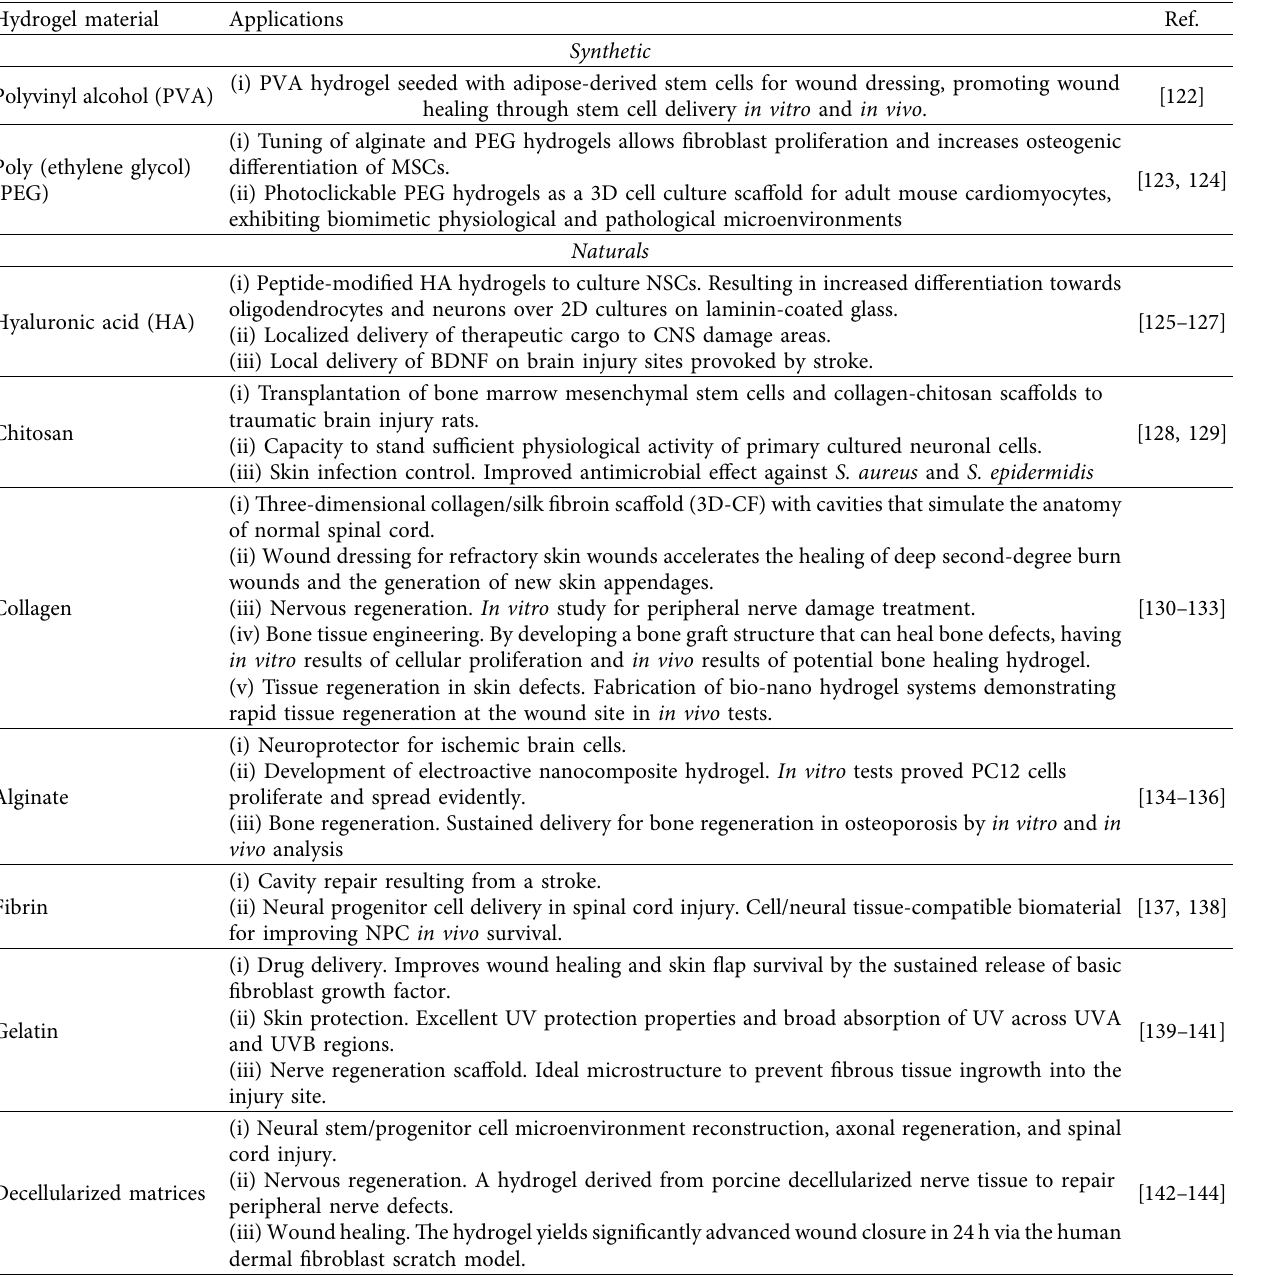
Table 1: A summary of some of the main applications of hydrogels in biomedicine and regenerative medicine. Hydrogel material